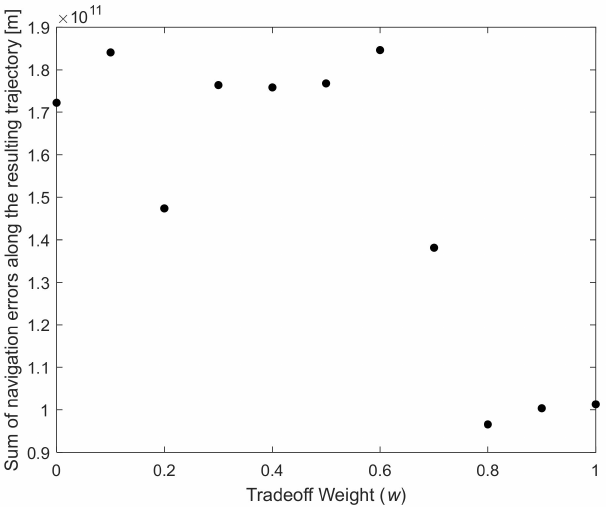
Figure 15. Sum of navigation errors along the resulting trajectory vs. tradeoff weight w